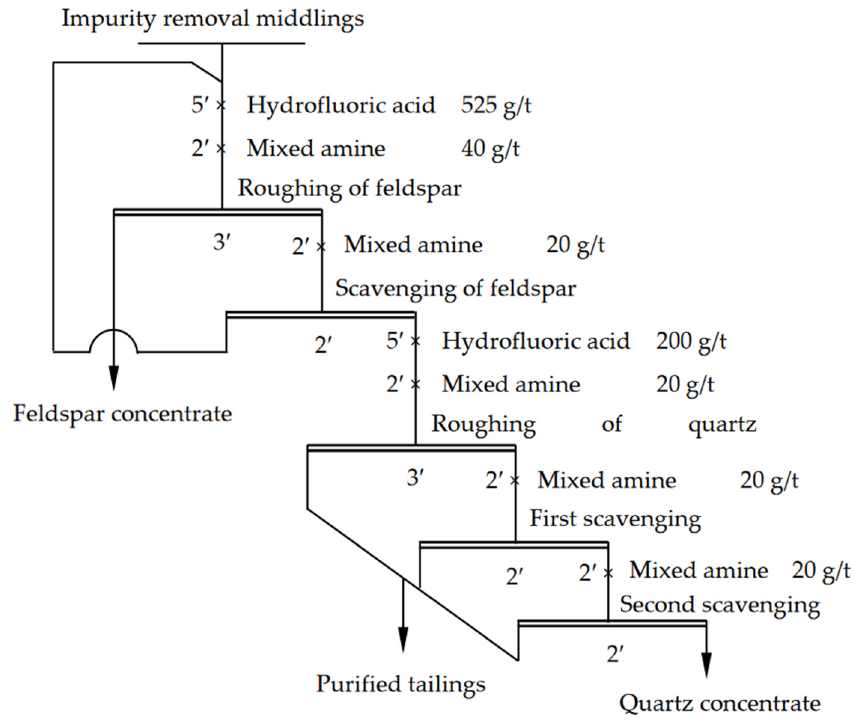
11 of 16 Figure 8. Flow sheet of impurity removal through flotation.